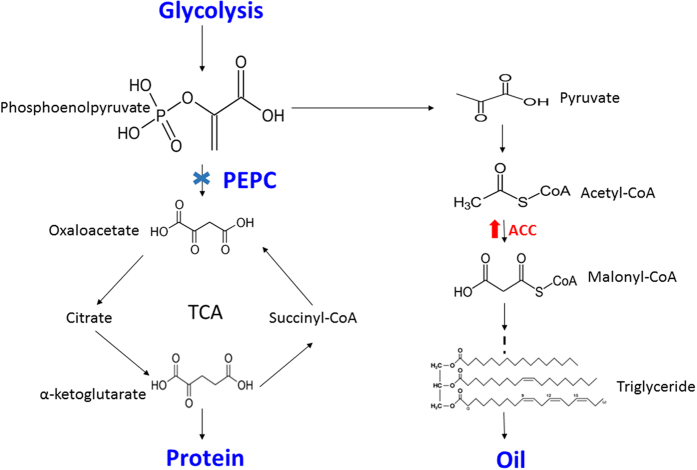
The schematic pathway for the distribution of carbon flow.PEPC (Phosphoenolpyruvate carboxylase) drives considerable carbon flux (Phosphoenolpyruvate) into TCA cycle and eventually control protein synthesis. Phosphoenolpyruvate is also the major substrate in the lipid biosynthesis pathway and ACC (Acetyl-CoA carboxylase) is the major enzyme that controls fatty acid biosynthesis. Since both protein and lipid biosynthesis pathway share the same substrate, the deceased consumption of phosphoenolpyruvate of either pathway is helpful to increase the final product (oil or protein) in the other pathway. In this report, the PEPC was downregulated via RNAi and theoretically decreased the carbon flow into the TCA cycle.